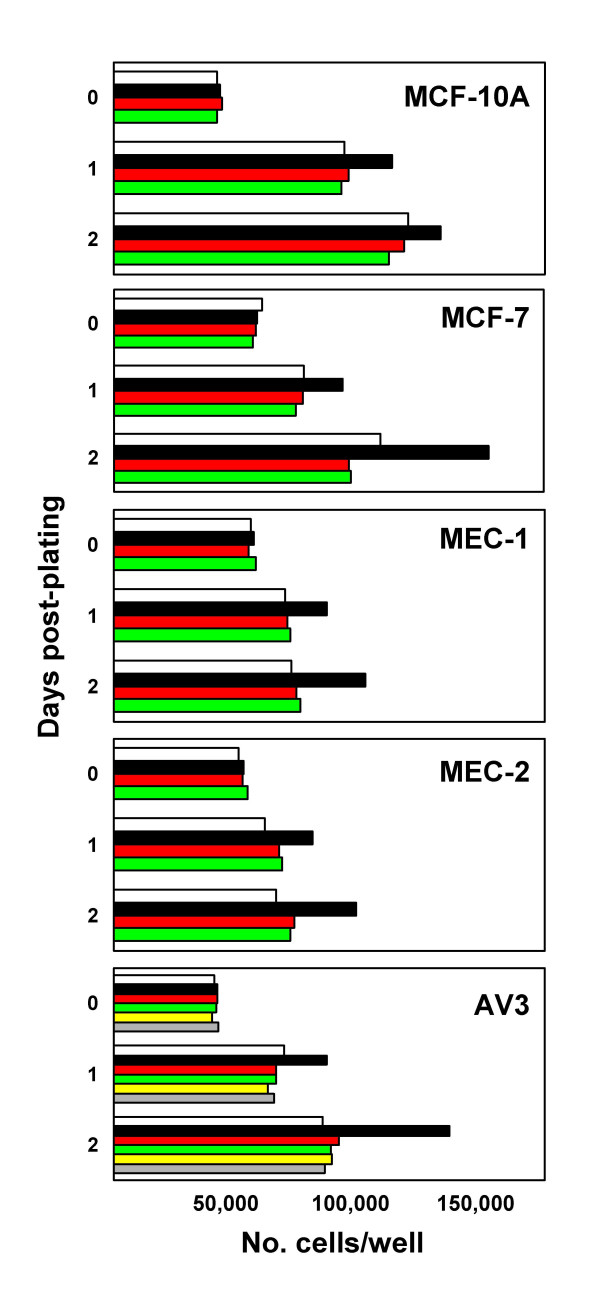
Neutralization by anti-Tat antibodies of the proliferative response to Tat of five different human epithelial cell lines cultured in low-serum medium. Cells were either left untreated (open bars) or exposed to 100 ng/ml Tat86aa (closed bars) at time 0. Cells were counted by microscopy at day-0, -1 and -2 after plating. Antibody tMAb-B (1 μg/ml) was mixed with Tat before treatment (red bars) or given alone (green bars). Bars represent the mean of three wells. Experiments on AV-3 cells (bottom panel) have also demonstrated the Tat-neutralizing activity of a rabbit polyclonal anti-Tat antibody: anti-Tat plus Tat (yellow bars) and anti-Tat alone (gray bars). Results are expressed as number of cells/well. Each bar represents the average of 3 different tests. Standard deviations of the mean are not reported, but were within 12% of the mean.